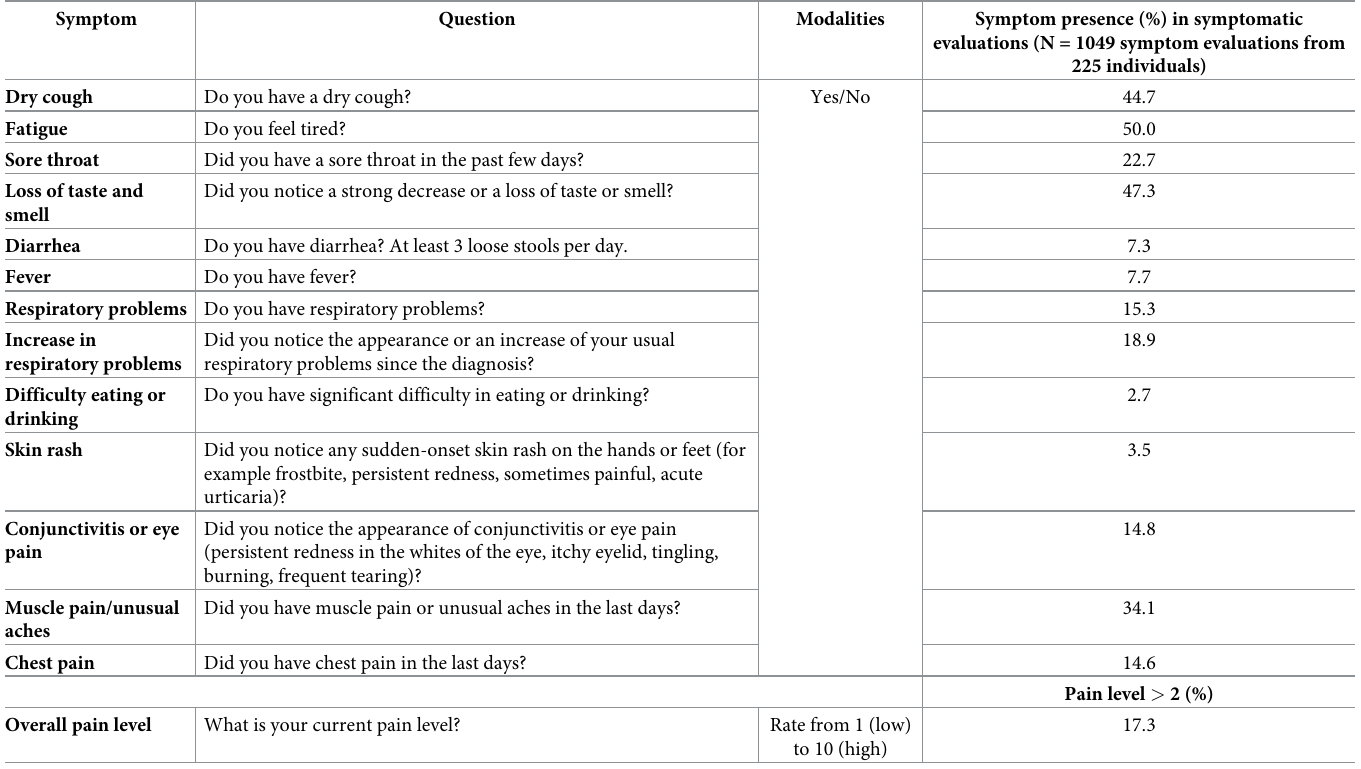
Table 1. Distribution of symptoms for participants with at least one symptom reported in the 14 days of follow-up.